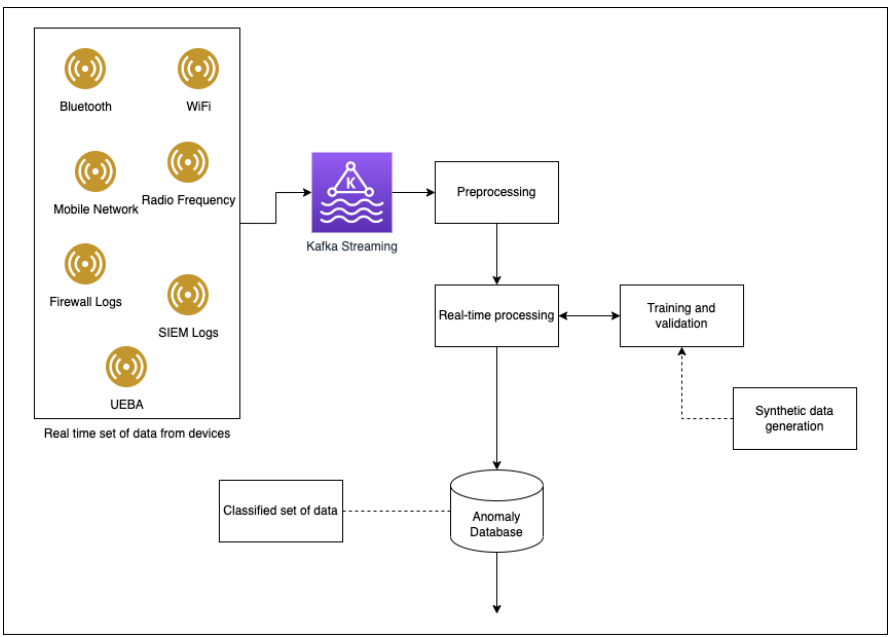
Figure 2. Modular architecture of the machine learning